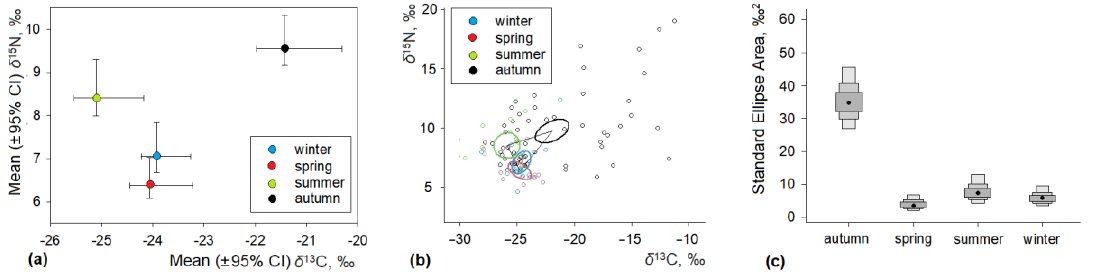
Figure 5. Seasonal position of M. musculus in isotopic space according to hair sample stable isotope ratios ( a ), ellipses, representing isotopic niche width areas of the mice, trapped at different seasons ( b ), and SEA density plots, representing the credibility intervals of the Bayesian SEA with shaded boxes encompassing the 50th, 75th and 95th (shown from dark to light) credibility intervals, according to the seasons ( c ).